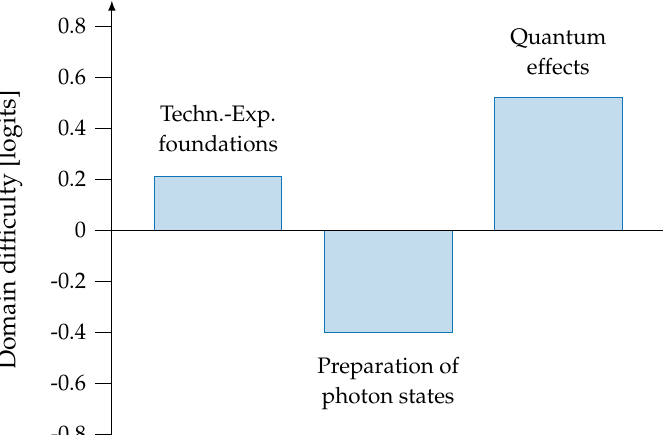
Figure 4. Average difficulties of the quantum optics concepts, evaluated by our concept inventory, measured in